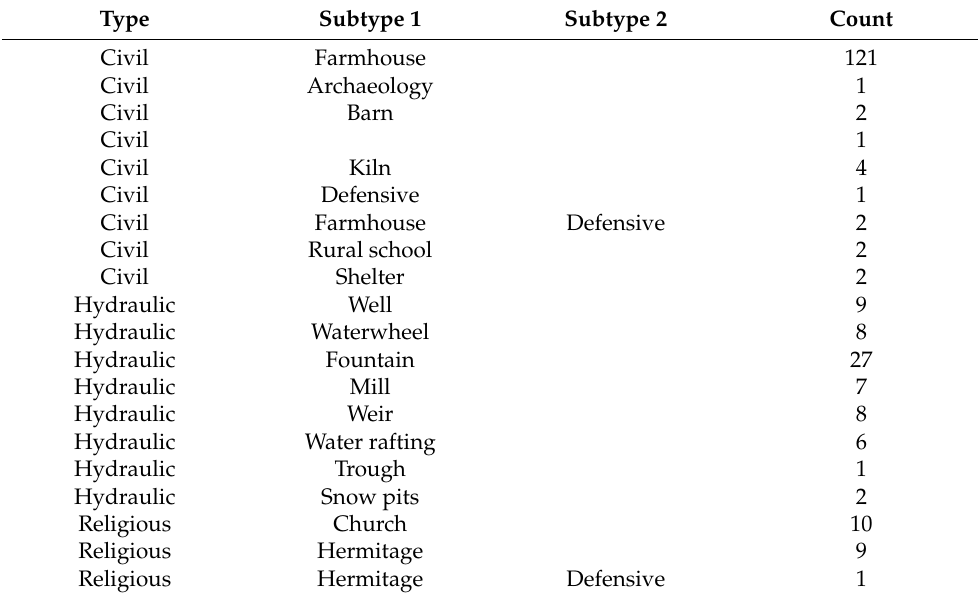
Table 1. Distribution of the cataloguing of the Penyagolosa area according to types and subtypes of elements.